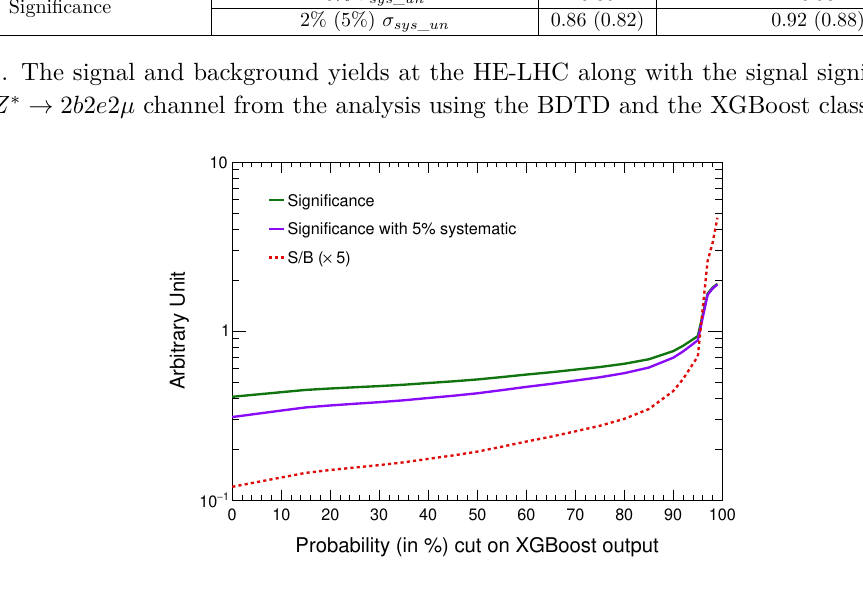
Figure 13 . The variation of significance (with ( 5% ) and without systematic uncertainty) and S/B is shown as a function of the probability cut on the XGBoost output for the b ¯ bZZ ∗ → b ¯ b 2 e 2 µ